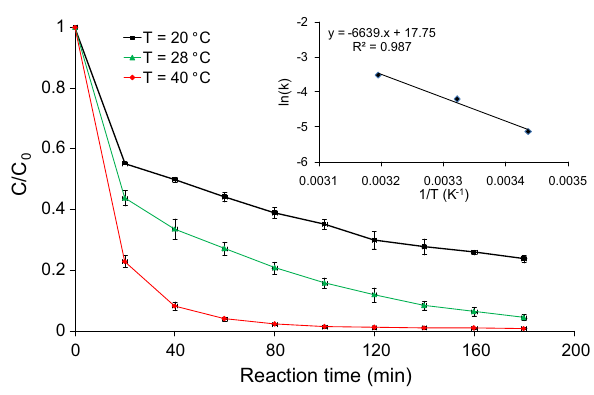
Fig. 9 Effect of temperature on the discoloration of the Rhodamine B and the Arrhenius law representation as inset (ln(K) versus 1/T): AC@Fe/3 0.27 g/L; C 0 = 50 mg/L; pH = 4.2; 8 mmol/L H 2 O